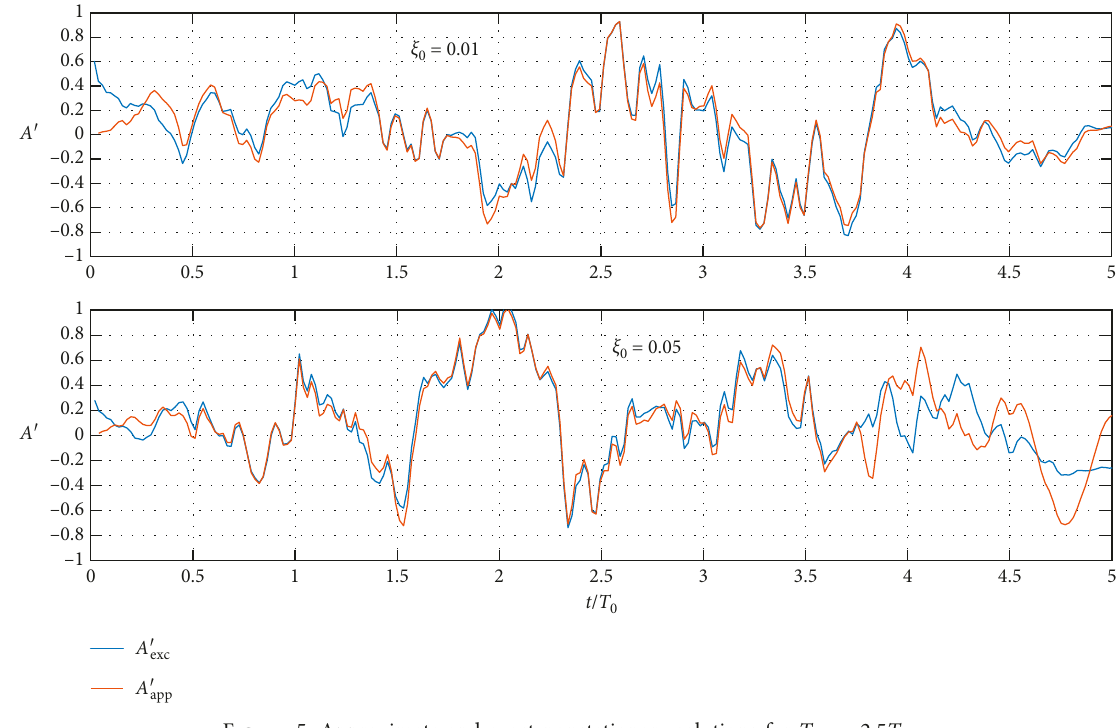
max (cid:31) 2.5 T 0 .